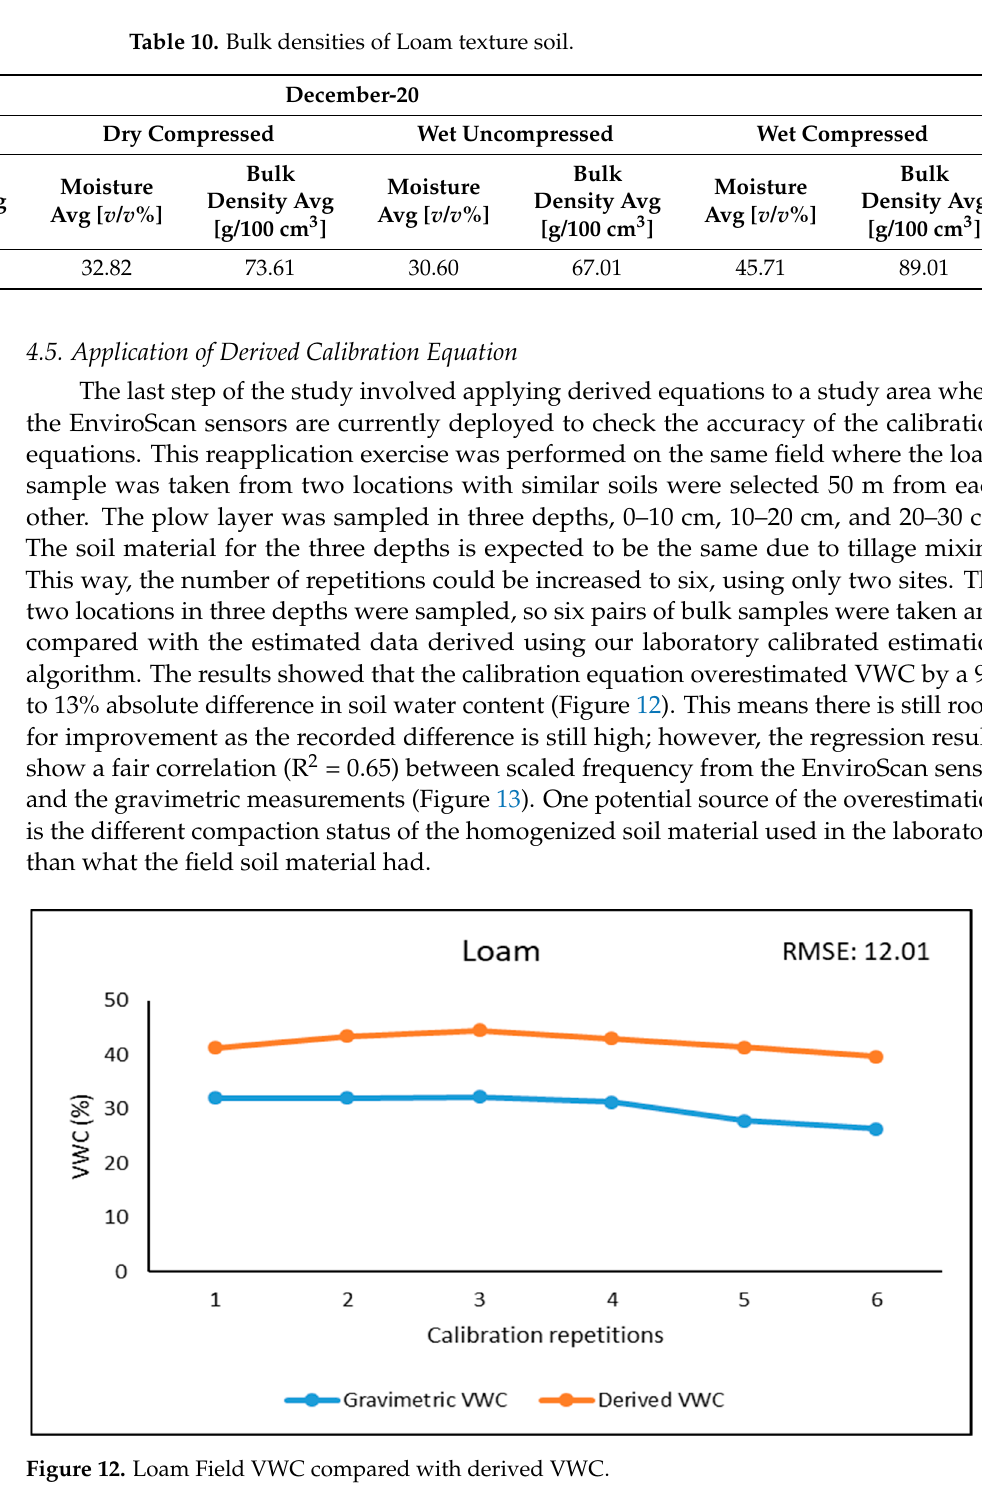
Figure 13. Fitting regression analysis of the derived calibration equation for Loam soils. 5. Discussion Calibration is one of the greatest challenges for field soil moisture measurements. The installation is time-dependent. Any disturbance of the site will decrease the representa- tivity of the measuring site. However, the variability of soil structural properties is very high and varies locally, of which this conflict is difficult to overcome. Calibration with high reliability can be achieved only with soil samples taken right next to the probe, but sampling in the sensed volume will change the soil properties and decrease the repre- sentativity.